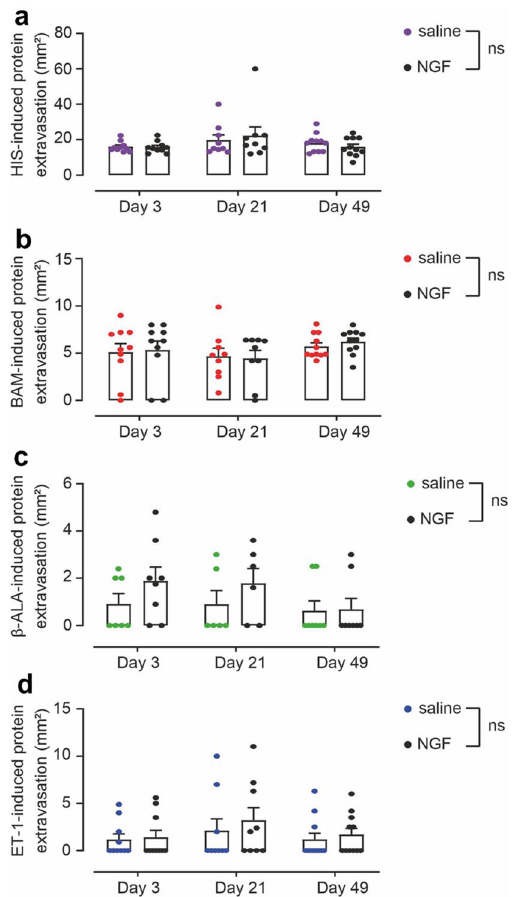
Figure 6. rhNGF does not impact pruritogen-induced protein extravasation. ( a–d ) Protein extravasation measured 5 min after iontophoretic delivery of HIS ( a ) or after injections of BAM8–22 ( b ), β-ALA ( c ), and ET-1 ( d ) at 3 days, 21 days and 49 days post injection of rhNGF (black symbols) and saline (colored symbols), respectively. No significant effects of rhNGF pretreatment were detected for any pruritogen at any experimental day (n.s.). Data are presented as mean ± standard error (SEM) with overlay of individual data